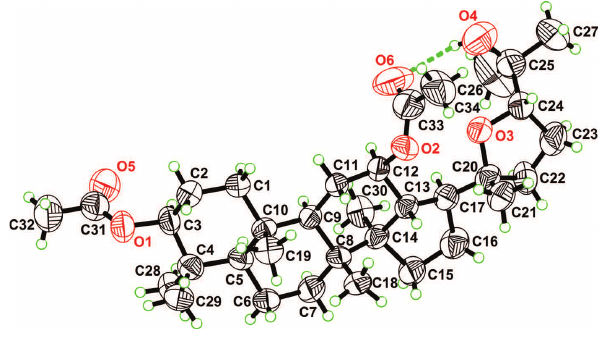
Table 1: Data collection and